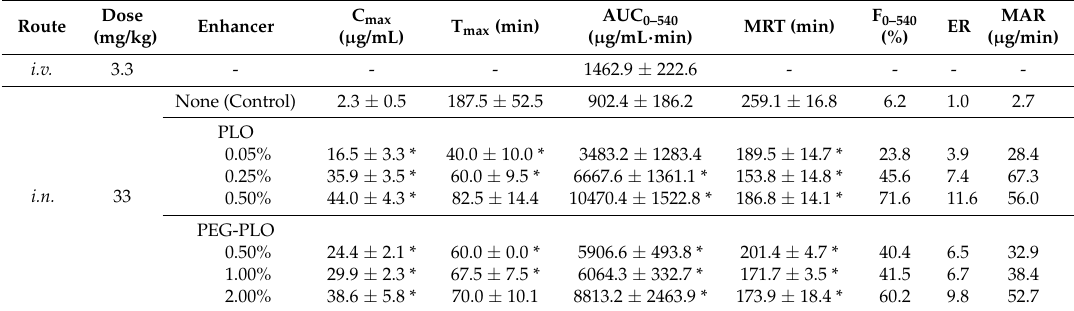
Figure 9. Plasma FD-4 concentration after i.n. administration in rats under the closed system. ( A ) PLO ( ● : Control, ■ : 0.05%, ♦ : 0.25% and ▲ : 0.50%); ( B ) PEG-PLO ( ● : Control, ■ : 0.50%, ♦ : 1.00% and ▲ : 2.00%). Each data point represents the mean ± S.E. ( n = 3–7). Table 3. Pharmacokinetic parameters of FD-4 after i.n. administration in rats under the closed system.